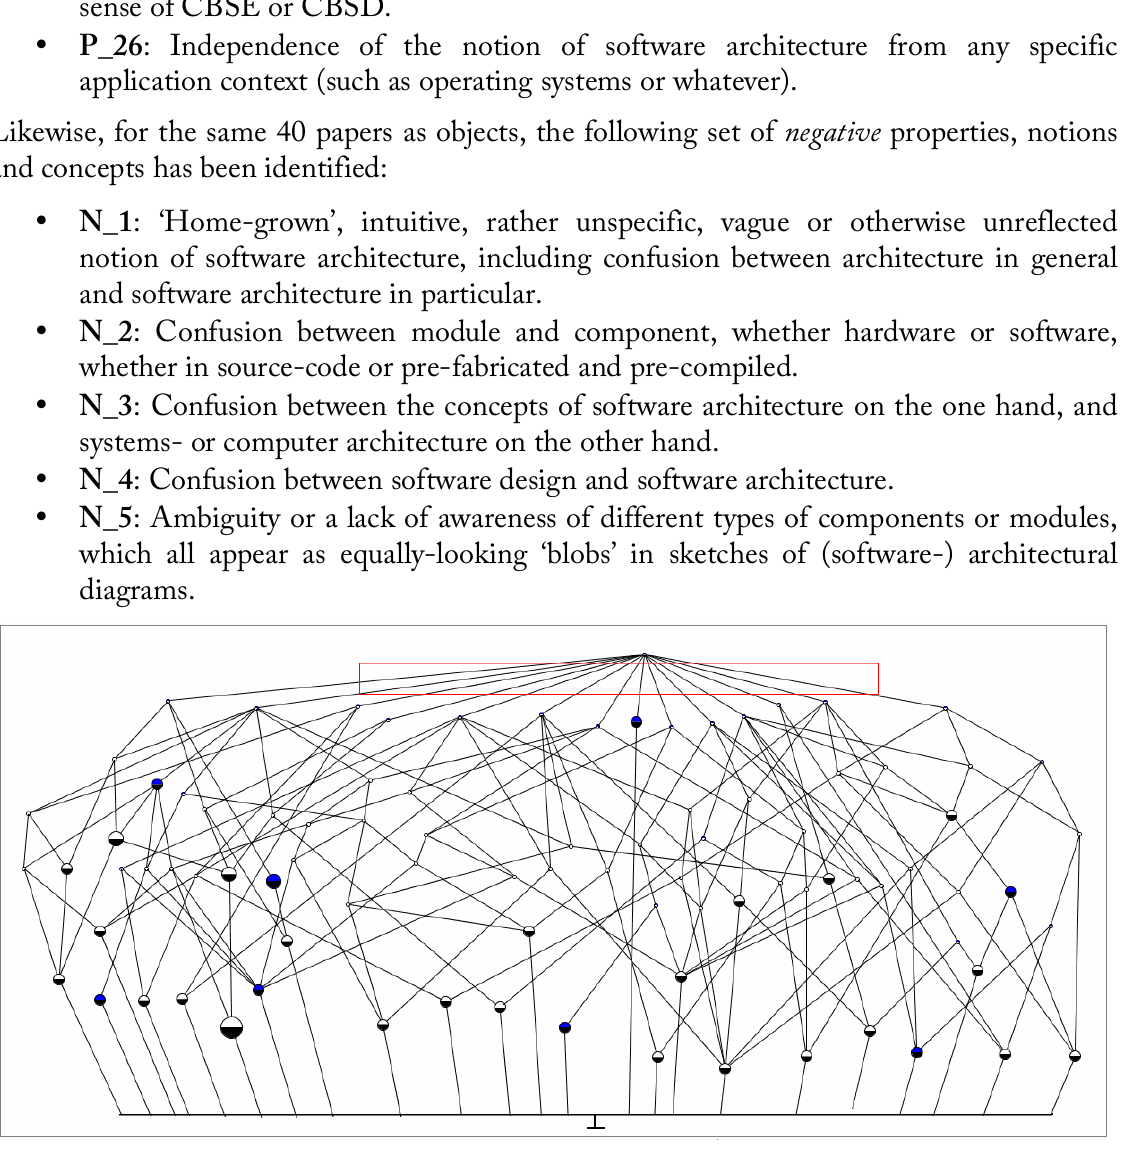
Figure 3. Lattice showing the semantic space of the most-cited software architecture papers in the ACM-DL, 1972-2011: The fourteen main conceptual branches are indicated by the red box immediately underneath the lattice’s top